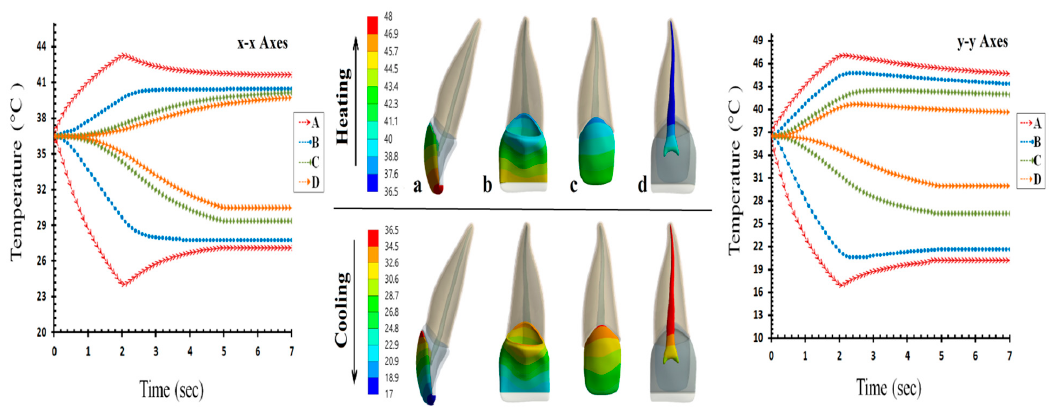
Figure 9. Temperature distributions in the conventional preparation design along the x-x and